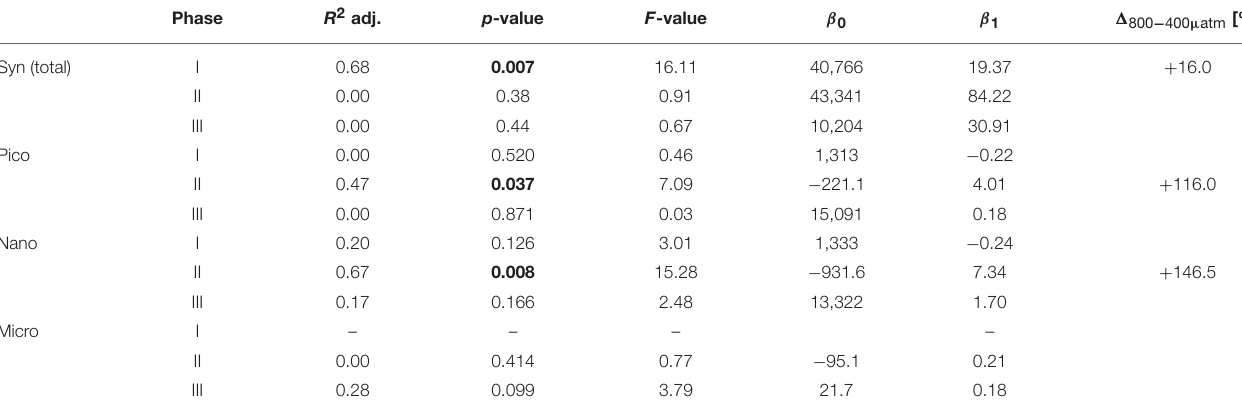
TABLE 2 | Results of linear regression for CO 2 effects on phytoplankton groups based on flow